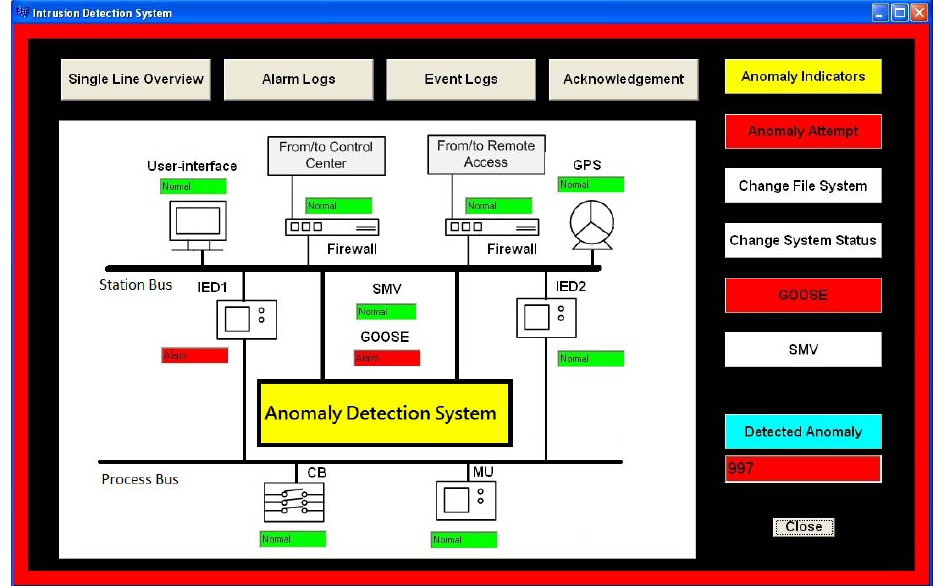
Figure 8. Implementation of the proposed ADS in a